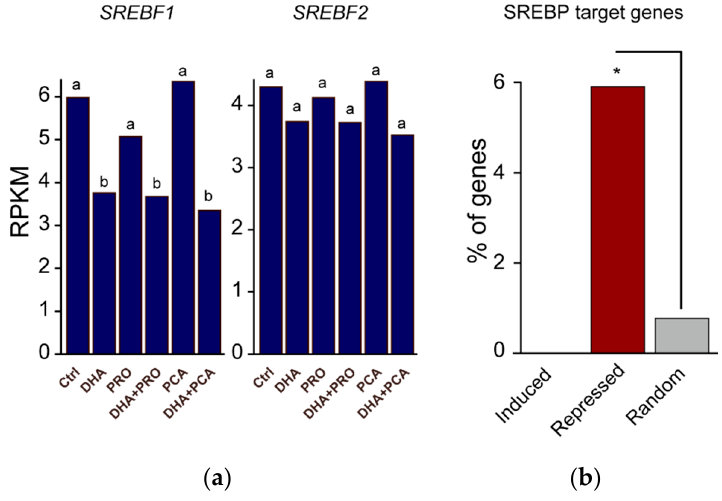
Figure 4. SREBPF1 , SREBPF2 , and SREBP-target gene expression. ( a ) SREBF1 and SREBF2 expression (RPKM: reads per kilobase per million mapped reads). Statistical analysis was carried out using one-way ANOVA followed by Tukey’s HSD test. Different letters indicate statistical significance ( p < 0.05); ( b ) The relative percent enrichment of SREBP-target genes within each cluster and random genes (* p < 4 × 10 − 9 , proportion test).